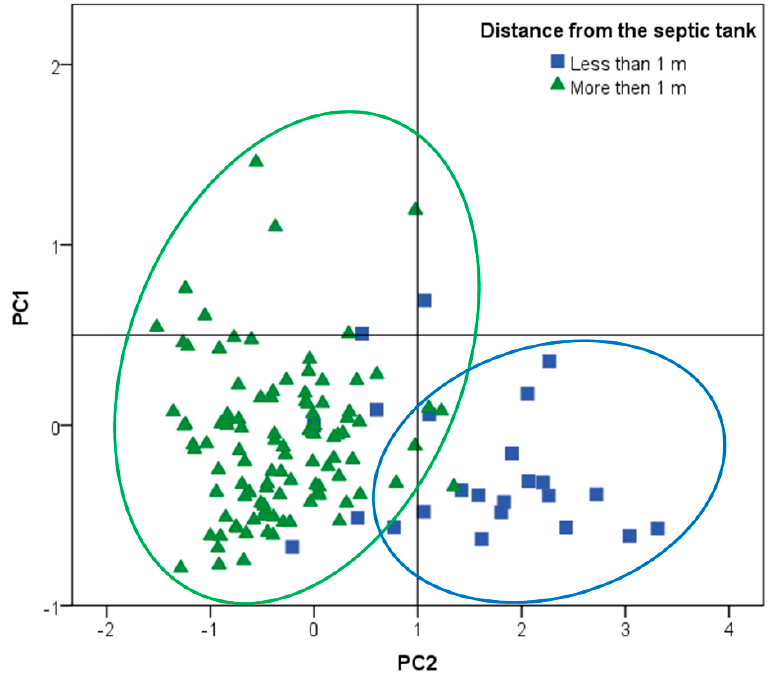
Figure 12. Bivariate plot of the scores of PC1 and PC2 by location of the monitoring wells.